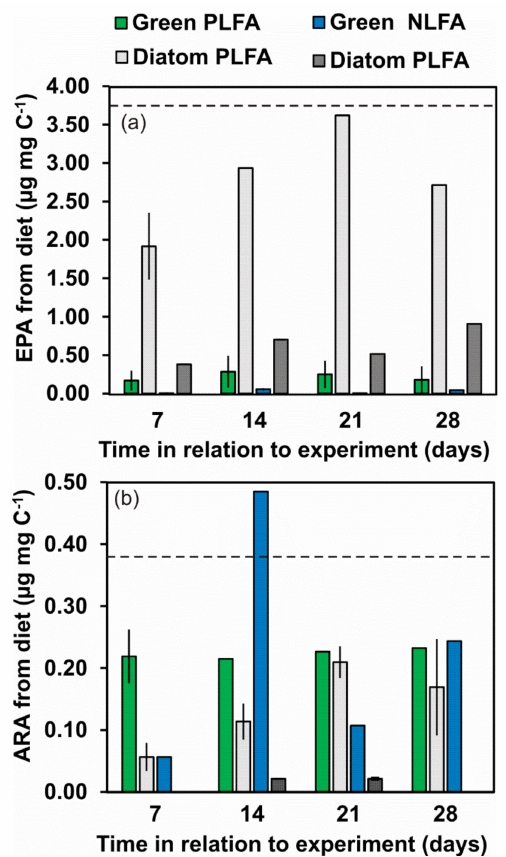
Figure 6. Calculated amount of eicosapentaenoic acid (EPA) ( a ) and arachidonic acid (ARA) ( b ) in NLFA and PLFA fraction which originated from the diet (green algae or diatom). Dashed line shows the EPA and ARA content of wild individuals that can be kept as desirable content of EPA and